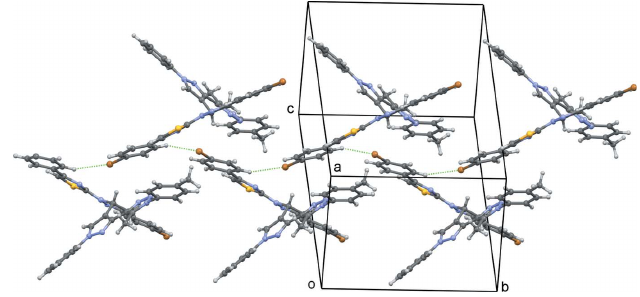
Figure 2 A segment of the crystal structure showing C—H (cid:3)(cid:3)(cid:3) Br contacts.